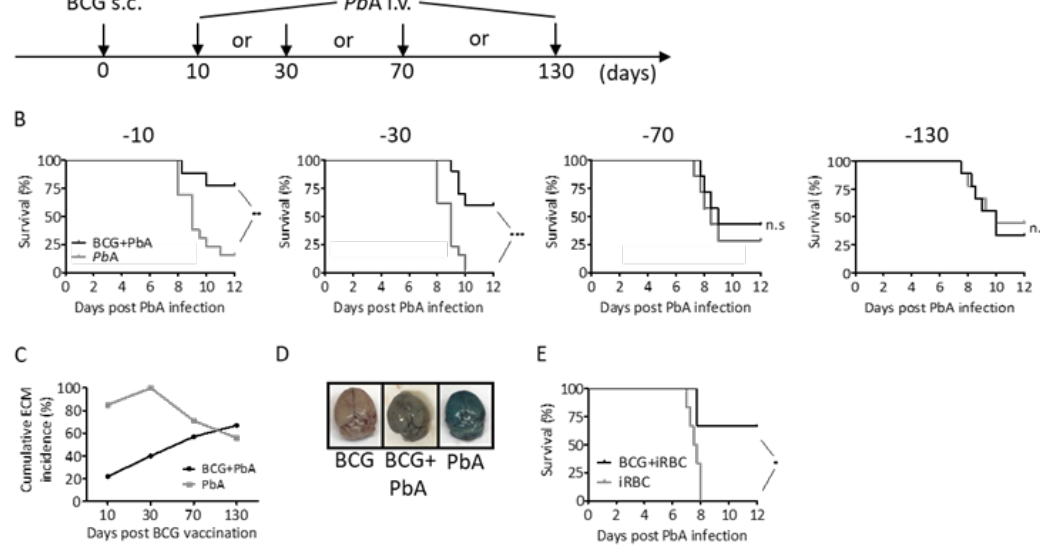
Figure 1. ECM development in previously naive or BCG-vaccinated mice. ( A ) Mice were s.c. immunized with 10 7 BCG followed by i.v. challenge with 10 4 PbA SPZ at different time points after BCG inoculation. ( B ) ECM-free survival in BCG immunized versus untreated (non-immunized) control animals following challenge with 10 4 PbA SPZ i.v. (data from two independent experiments are shown, respectively; n = 9–13 for −10; n = 10–13 for −30; n = 7 for −70; n = 9 for −130; ** p < 0.01; *** p < 0.001; n.s. = not significant; log rank test). ( C ) Cumulative ECM incidence (%). ( D ) Evans blue staining of brains on day 8 of PbA infection (representative images from one out of five mice per group are shown, respectively). ( E ) Survival of previously naive or BCG-immunized mice after challenge with PbA-iRBC (n = 6; * p < 0.05; log-rank